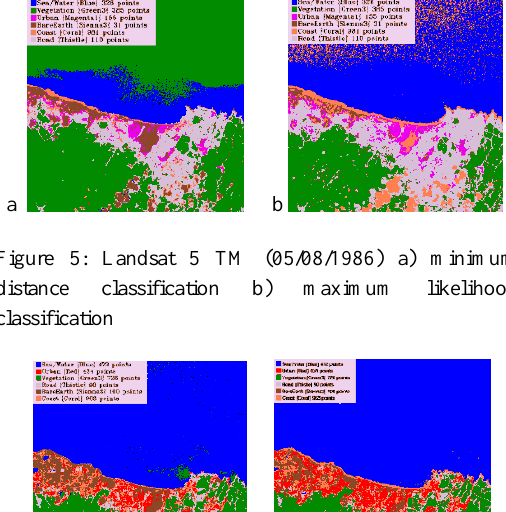
Figure 8: Landsat 7 TM (28/07/2015) a) minimum distance classification b) maximum likelihood classification.